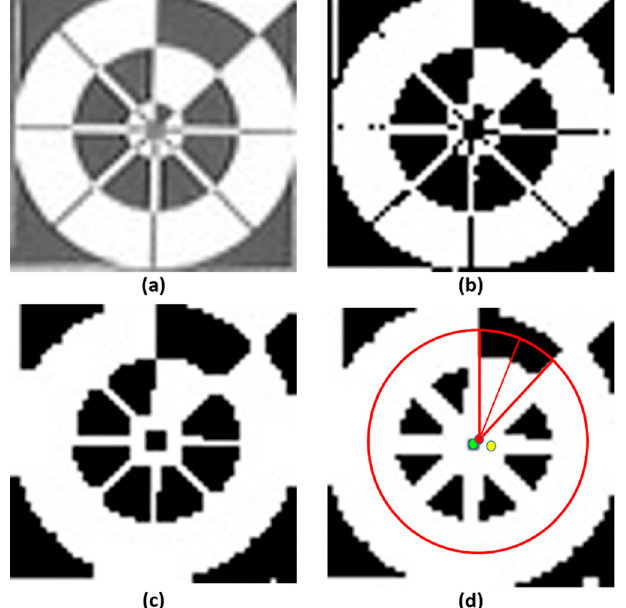
Figure 9. Example images of procedure of Profile Checker v2 algorithm. ( a ) Input image; ( b ) image by adaptive thresholding; ( c ) image by morphological transform; and ( d ) detected marker center and direction.